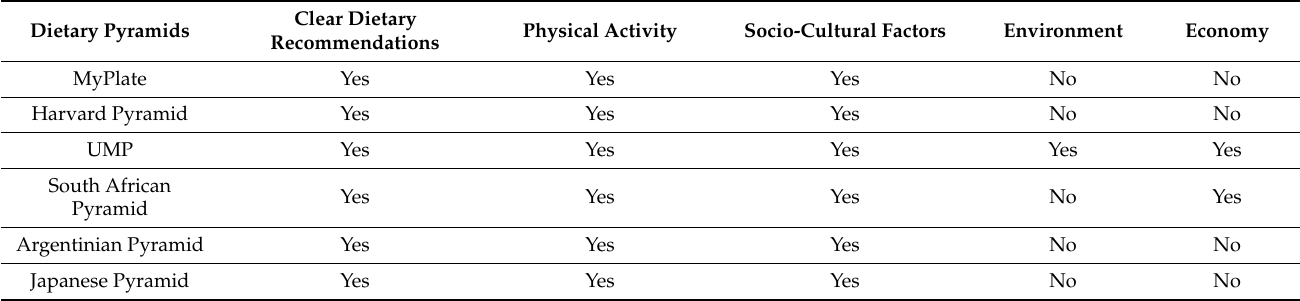
Table 1. Points addressed by the Updated Pyramids from MyPlate and the Harvard Pyramid in the US, the Updated Mediterranean Pyramid (UMP), and the Argentinian and Japanese Pyramids. Clear Dietary Dietary Pyramids Physical Activity Socio-Cultural Factors Recommendations